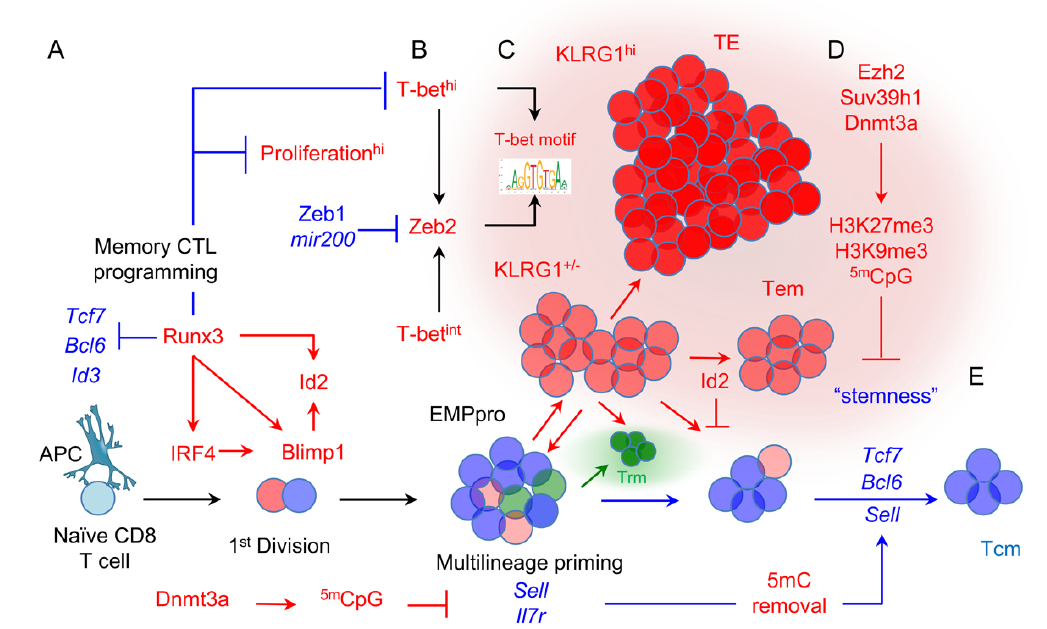
Figure 3. An integrated model of memory CD8 T-cell differentiation. ( A ) Individual naïve CD8 T cells undergo memory CD8 T-cell programming wherein they acquire fundamental traits of fully developed memory CD8 T cells prior to the first cell division. ( B ) The growing nascent CD8 T-cell population comprises a transitional population of effector and memory precursor progenitor (EMPpro) cells that are metastable at the chromatin and transcriptional level and can give rise to all subsets of differentiated CD8 T-cell progeny. ( C ) A small number of EMPpro cells randomly undergo massive proliferation coupled to higher expression of multiple transcription factors (TFs) in response to inflammatory signals that drive transcription underlying the phenotypic and functional profiles of terminally differentiated CD8 T cells. ( D ) Multiple chromatin regulatory factors that methylate DNA and histones persistently repress genes that otherwise favor quiescence, lymphoid retention, and overall “stemness” and thus enforce terminal differentiation. Factors generally associated with terminal CD8 T-cell differentiation (red) and memory (blue) are highlighted by color but are not intended to imply exclusive